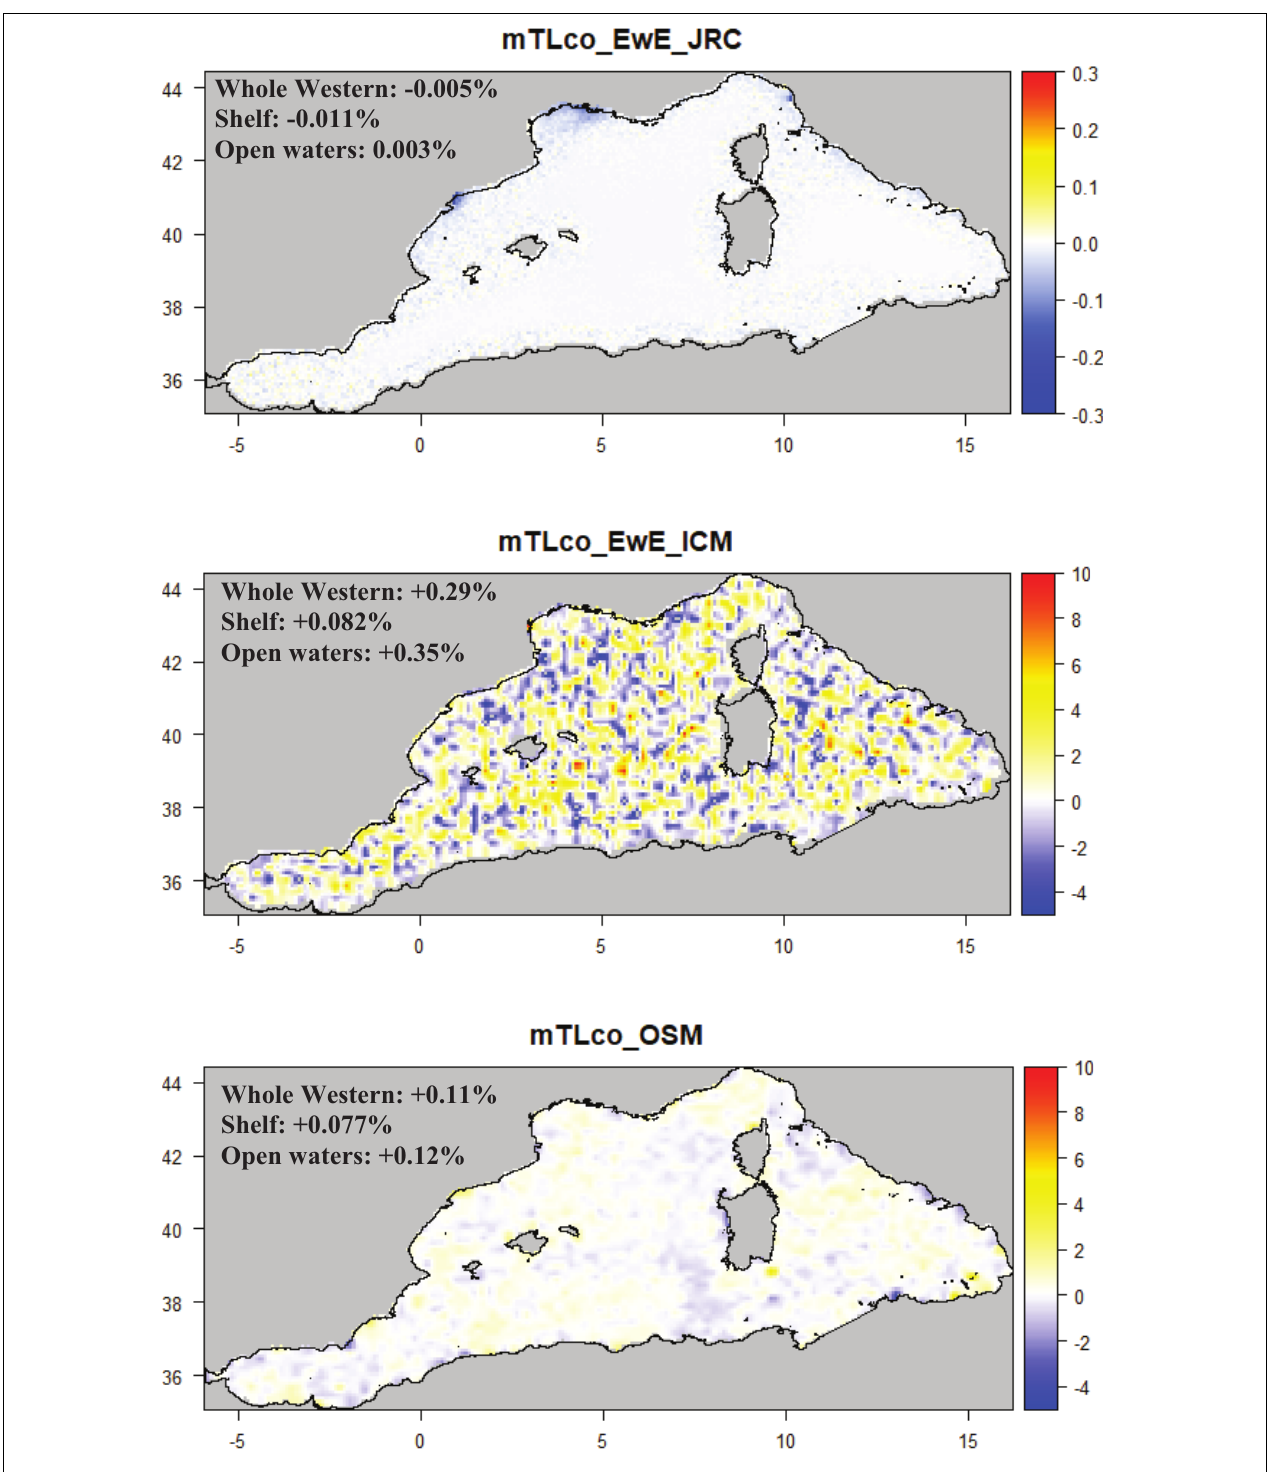
FIGURE 7 | Maps representing the mean change (%) for the Mean trophic level of the community (mTLco) per model type. Mean values were calculated considering the whole Western sub-region, shelves ( < 200 m) and open waters ( > 200 m). Note that the color scale of mTLco_EwE_JRC is different from the one of mTLco_EwE_ICM and